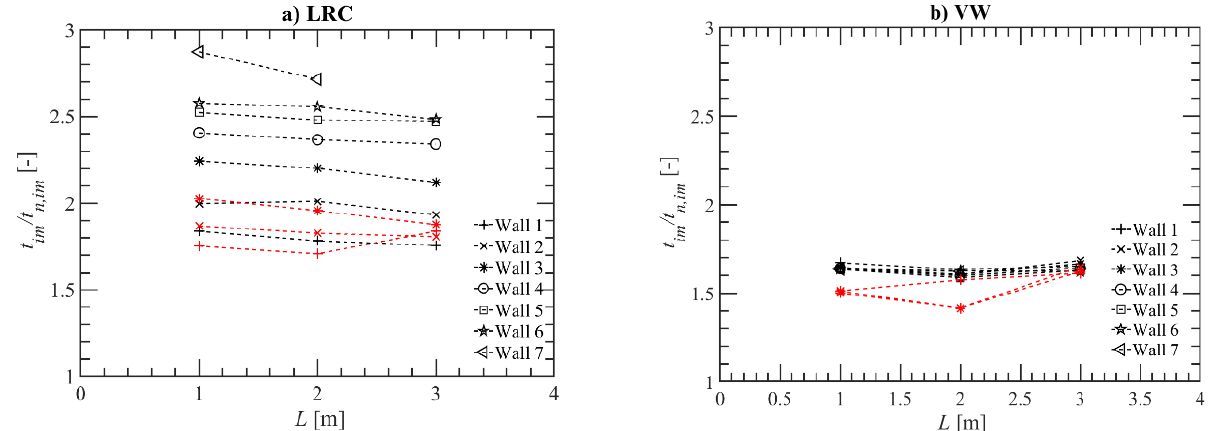
Figure 14. Time of impact in LRC and VW (black— d o = 0.9 m and red— d o = 0.6 m).